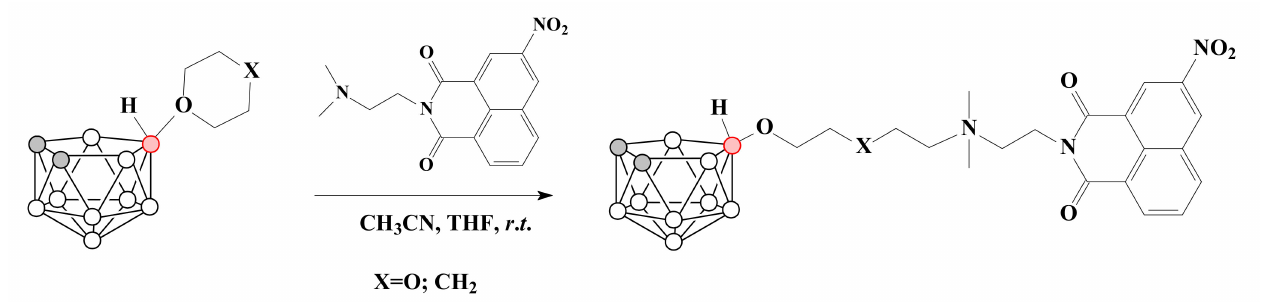
Scheme 15. The synthesis of nido -carborane-based conjugates with mitonafide. The reactions of 1,4-dioxane derivative of nido -carborane with 4-aminophenol in tetrahydrofuran in mild conditions led to the formation of the corresponding ammo- nium derivative 10-(4-OH-C 6 H 4 )-NH 2 CH 2 CH 2 OCH 2 CH 2 O-7,8-C 2 B 9 H 11, whereas the treat- ment of 10-O(CH 2 CH 2 ) 2 O-7,8-C 2 B 9 H 11 with 2-amino-1,3-propanediol resulted in a mix- ture of 10-(HOCH 2 ) 2 CHNH 2 CH 2 CH 2 OCH 2 CH 2 O-7,8-C 2 B 9 H 11 and [(HOCH 2 ) 2 CHNH- N , N -(10,10 (cid:48) -CH 2 CH 2 OCH 2 CH 2 O-7,8-C 2 B 9 H 11 ) 2 ] − [71]. At the same time the reaction with n -butylamine led only to [ n -C 4 H 9 NH-(10-CH 2 CH 2 OCH 2 CH 2 O-7,8-C 2 B 9 H 11 ) 2 ] − [68] (Scheme 16).